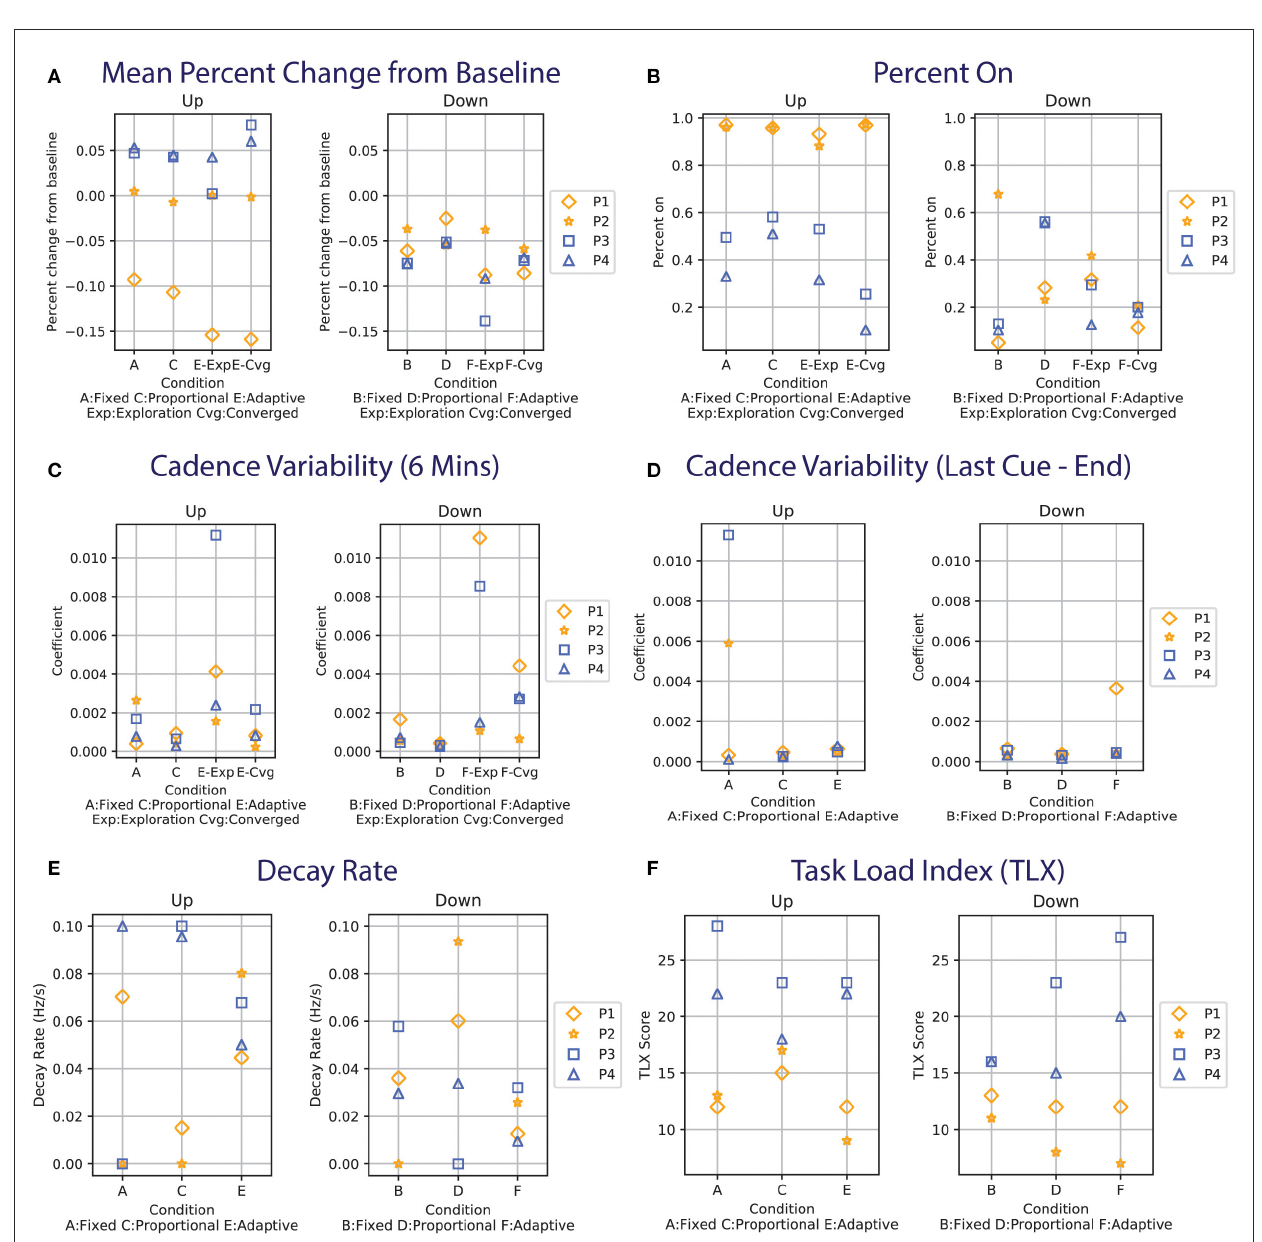
FIGURE2 (A) Mean percent change from baseline for each participant. For P1&P2 (shown in yellow), ω target is 15 % . ω target is 10 % for P3&P4 (in blue). The left panel shows the UP conditions and the right are the DOWN conditions. Data with similar values may be overlapping (e.g., P2&P3 in E-Exp, Up). (B) Percent on time during the first 6 min of the experiment. (C) Cadence variability computed using the coefficient of variation during the first 6 min of the experiment. (D) Cadence variability during the retention phase (last minute of the experiment). (E) Decay rate computed by fitting an exponential function to the data from the last provided cue (see orange lines in Figures 1B–D). (F) Task Load Index for the